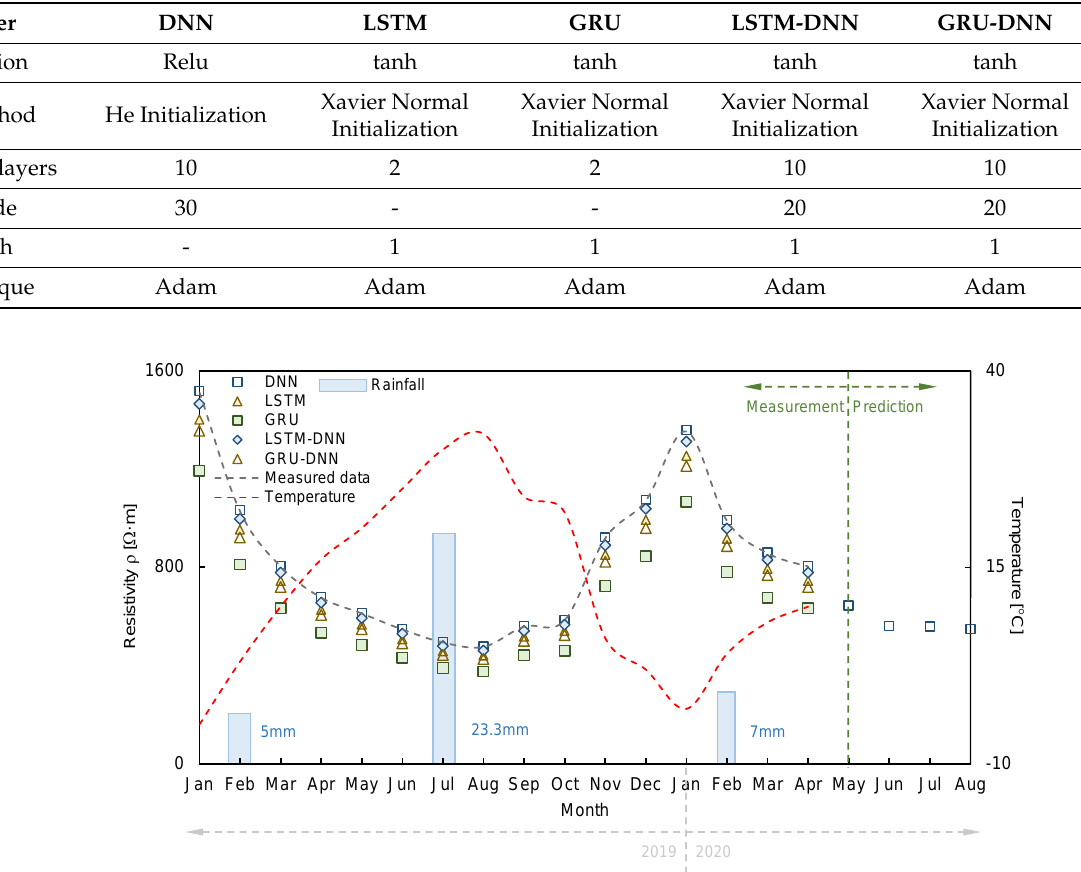
Figure 7. Pattern analysis by comparison of measured and predicted electrical resistivity.